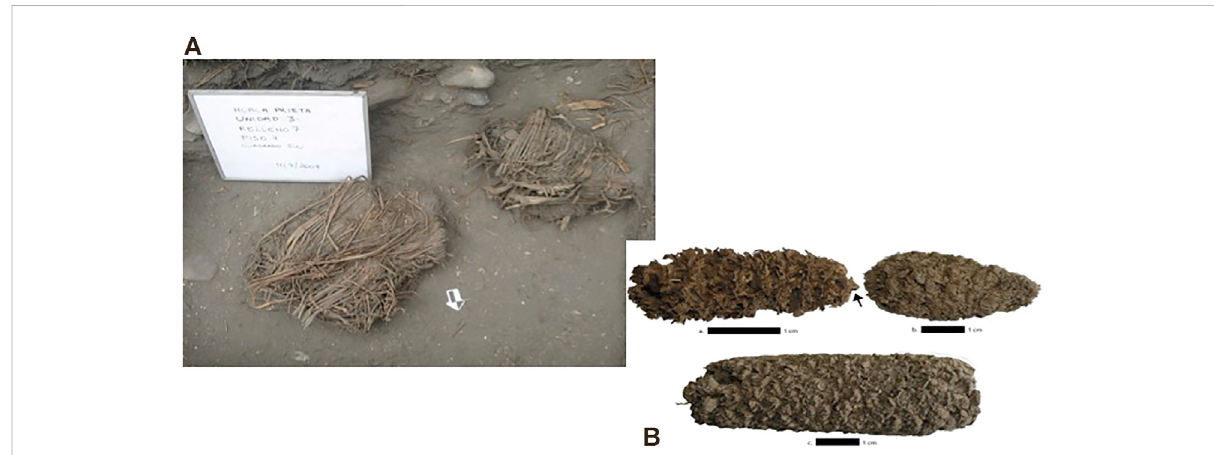
FIGURE 7 (A) Two tied- and -wrapped reed bundles containing coca leaves, marine shells, and fragments of textiles that were offerings placed on a pathway to the top of the Huaca Prieta mound and dated ~5,500 BP; (B) Maize cobs dated to ~6,500 – 6,000 BP from the Paredones mound (Grobman et al.